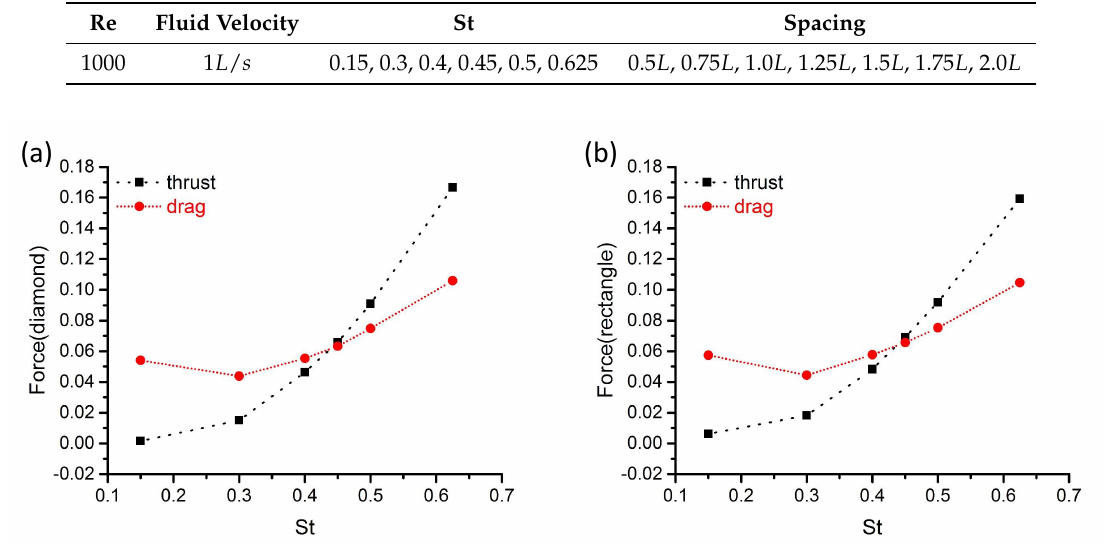
Table 2. The St number and spacing in the diamond or rectangle swarm test.